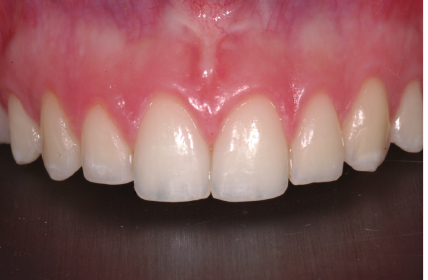
Figure 13: Uneventful healing with proper display of the